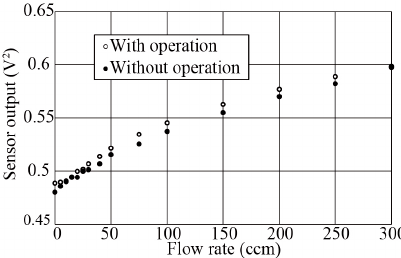
Figure 6. Effect of flow-direction sensor operation on flow rate measurement.